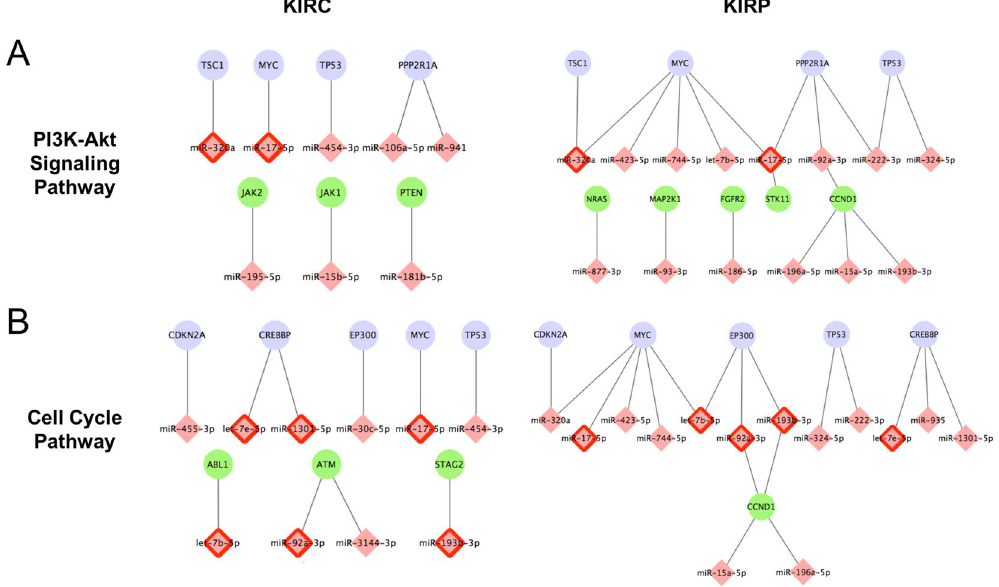
Figure 5. MiRNA-mediated gene regulation involved in two functional pathways in the early stage of KIRC and KIRP (miRNAs: pink diamonds; genes: ellipses). ( A ) PI3K-Akt Signaling Pathway; ( B ) Cell Cycle Pathway. Purple nodes denote the common genes between KIRC and KIRP; pink diamonds with red border indicate the common miRNA regulators; green ellipses are the condition-specific cancer genes.